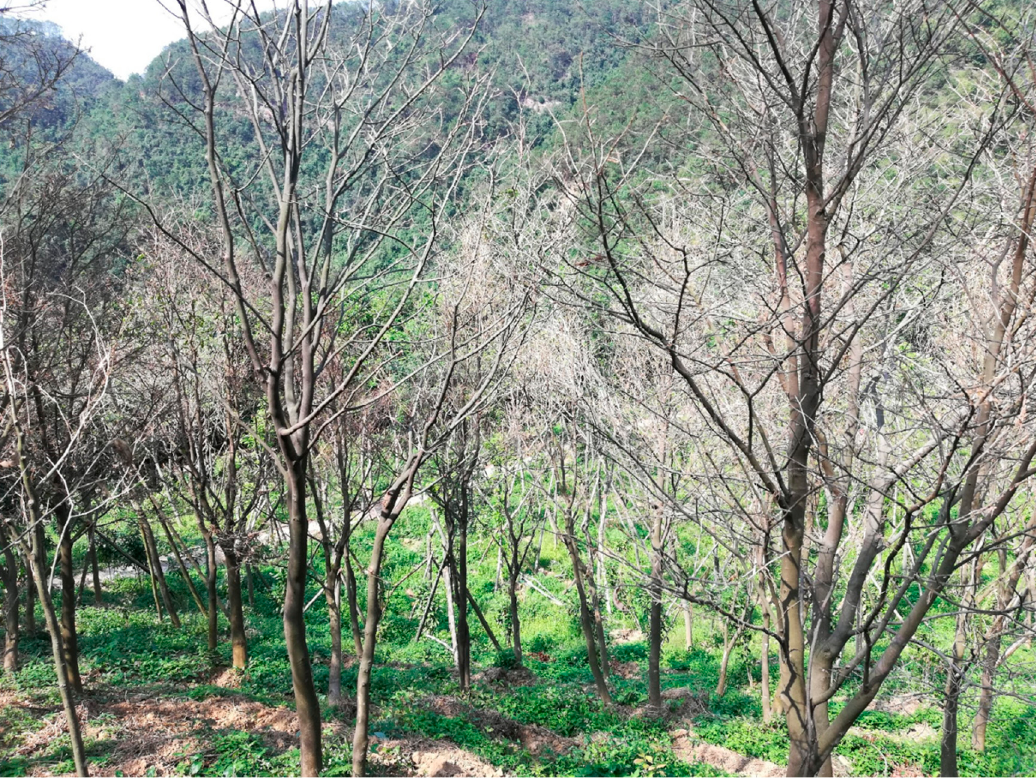
Figure 1. The outbreak of Heortia vitessoides Moore usually causes the complete defoliation of Aquilaria sinensis (Lour.) Gilg trees. The picture was taken in an Aquilaria sinensis plantation in Zhaoqin, Guangdong, China, on 13 November 2018 by Liping Tang.